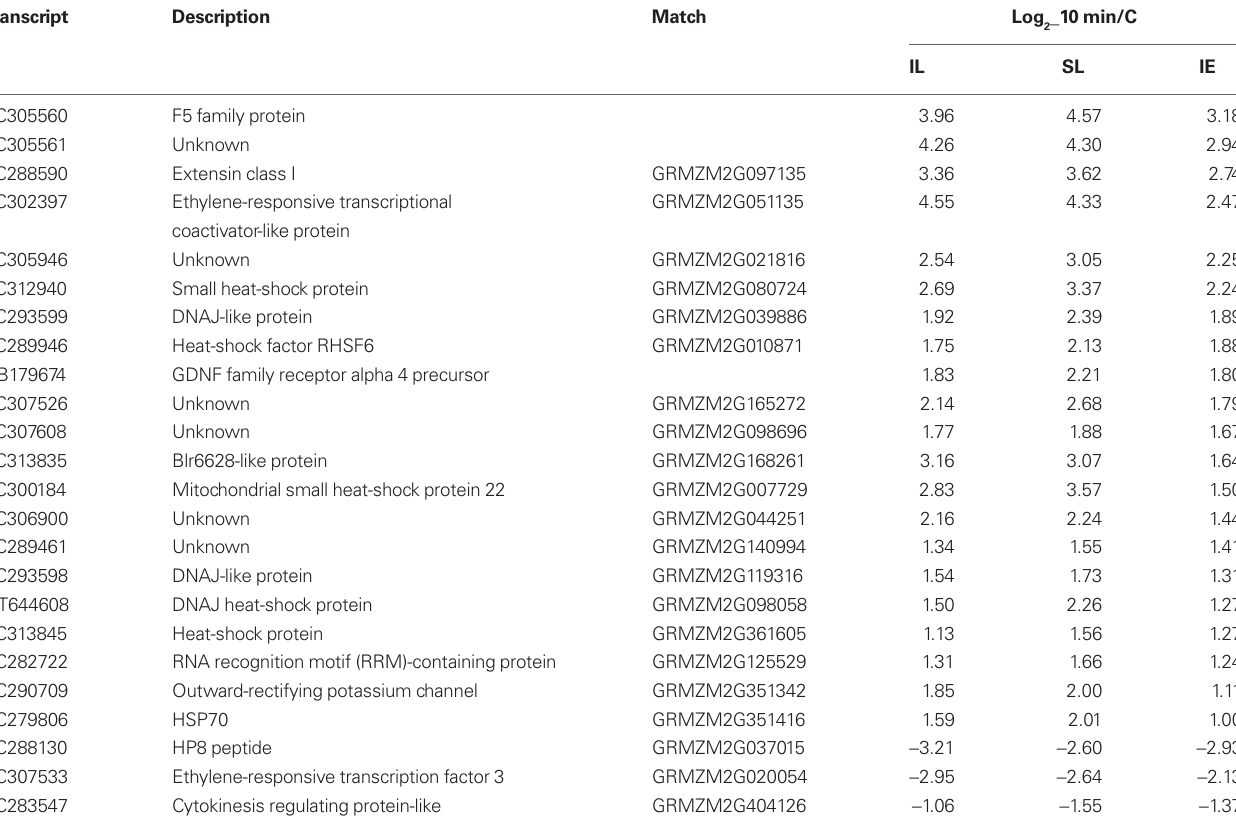
Table 3 | List of transcripts that are only UV-B-regulated in all irradiated and shielded leaves and immature ears after 10 min of exposure.